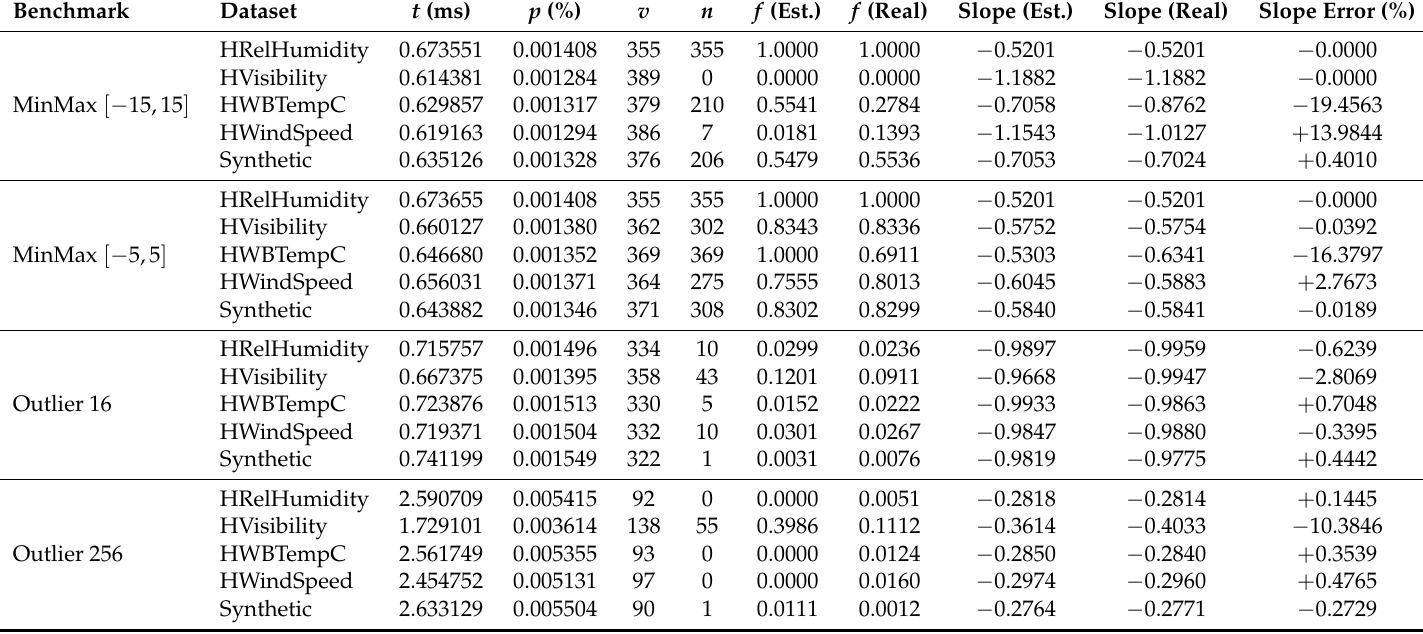
Table A3. Execution time results in cloud-prone